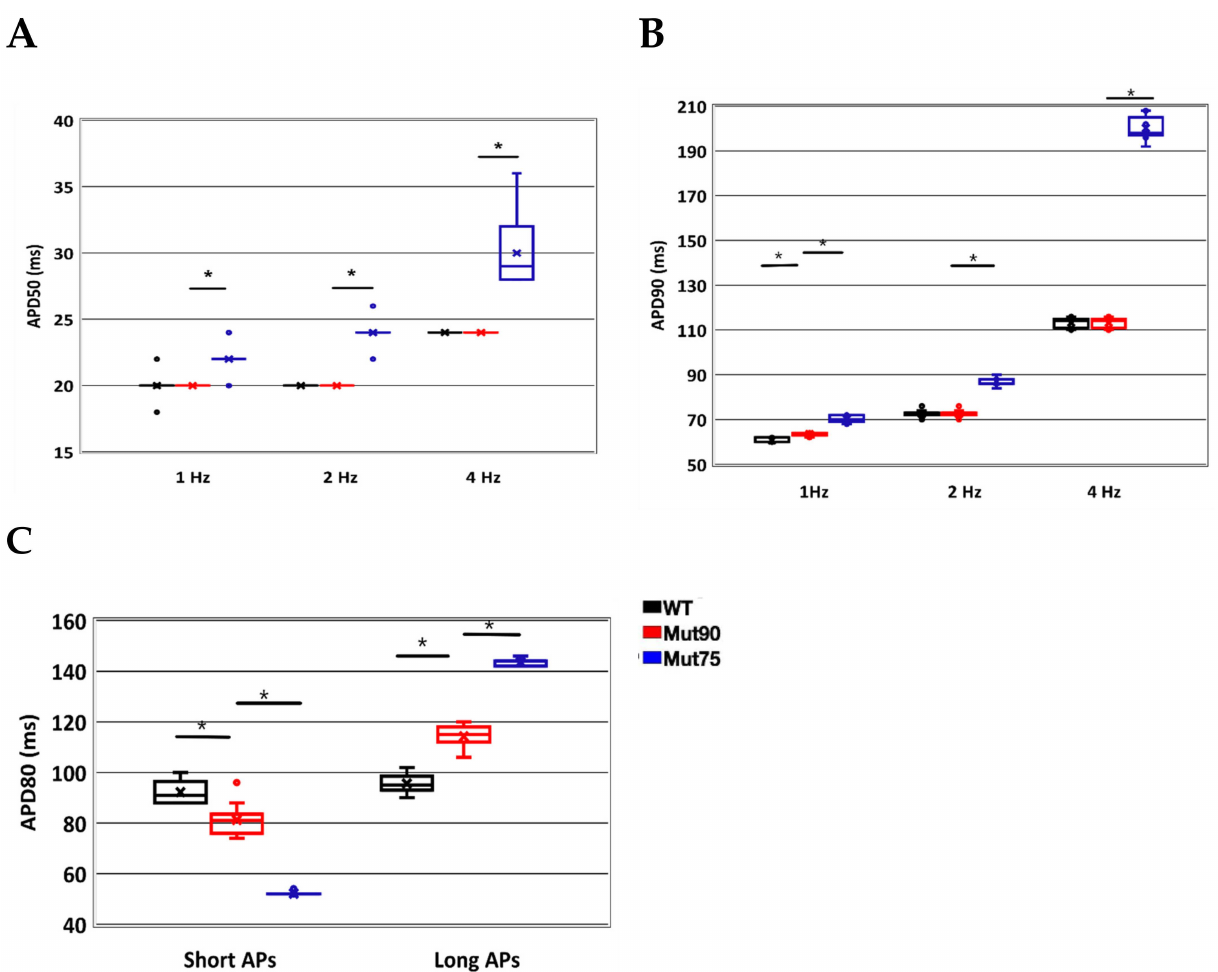
Figure 7. Reduced CaM inactivation impact on action potential at different pacing